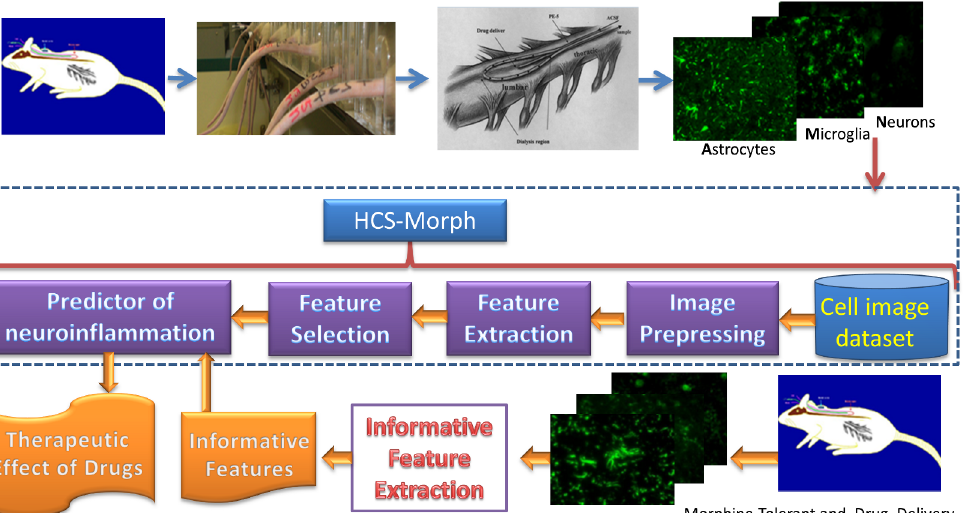
Fig 1. Flowchart of the proposed HCS-Morph method with materials. The computer-aided image diagnosis system facilitates developments of the tolerance therapy with anti-neuroinflammation drugs. A) Producing training images of neuroinflammation and non-neuroinflammation for astrocytes, microglia, and neurons. The procedure includes rat preparation and intrathecal drug delivery, anti-nociceptive test, spinal cord immunostaining sections, and image acquisition. B) Designing a prediction platform of neuroinflammation based on the HCS-Morph method. C) Evaluating effects of the tolerance therapy with anti-neuroinflammation drugs from immunostaining